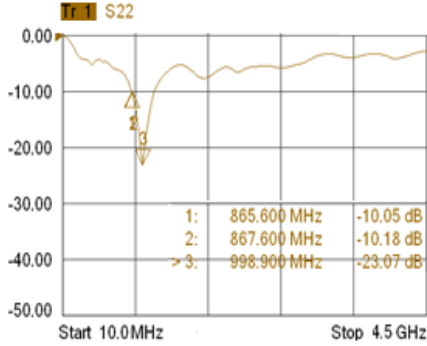
Figure 7. Measured return loss of the proposed embedded RFID